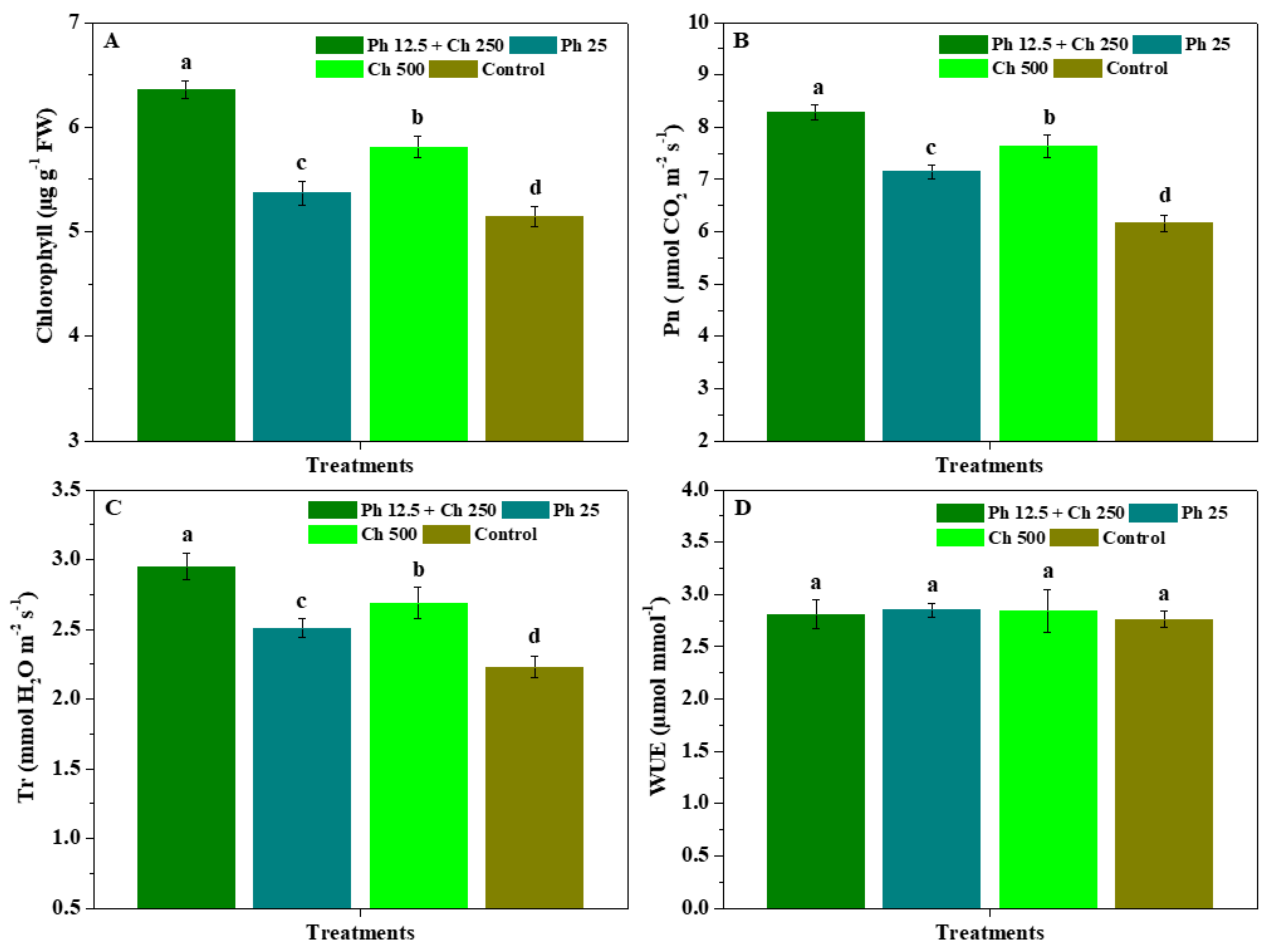
Figure 3. The impacts of physcion + chitosan, physcion, and chitosan on the chlorophyll ( A ), Pn ( B ), Tr ( C ) and WUE ( D ) of leaves. The significant differences in the five treatments at 5% ( p < 0.05) level are stood by different letters. Error bar represents the SD of three duplicates.